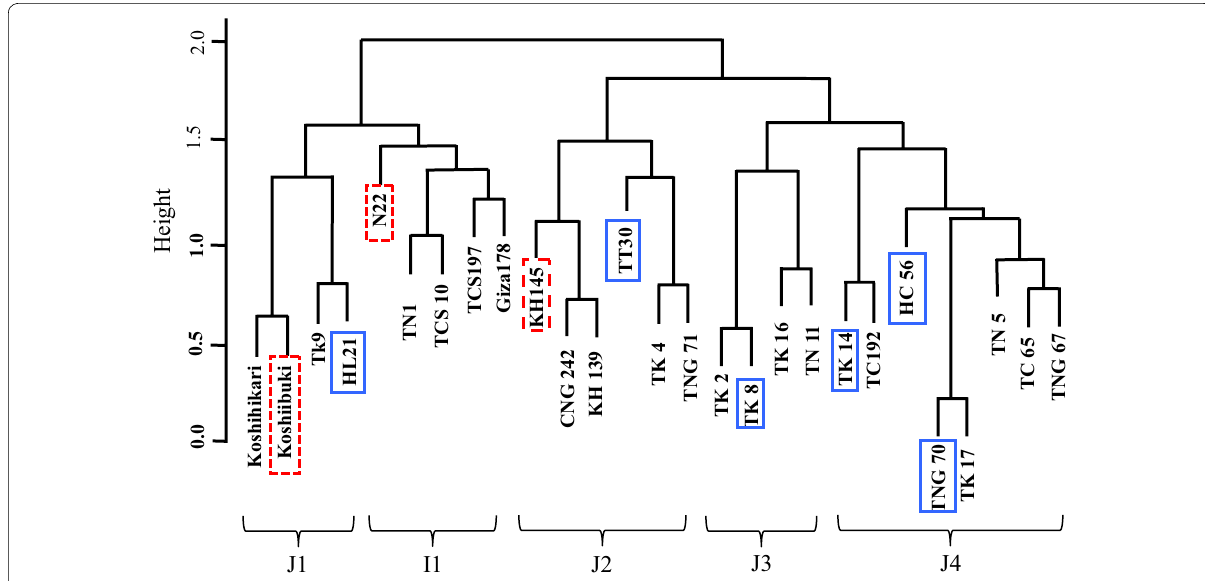
Fig. 2 Distribution of rice varieties on the phylogenetic dendrogram. The tolerant and sensitive varieties in the tree are labeled as below: : exhibited thermosensitivity, : exhibited high